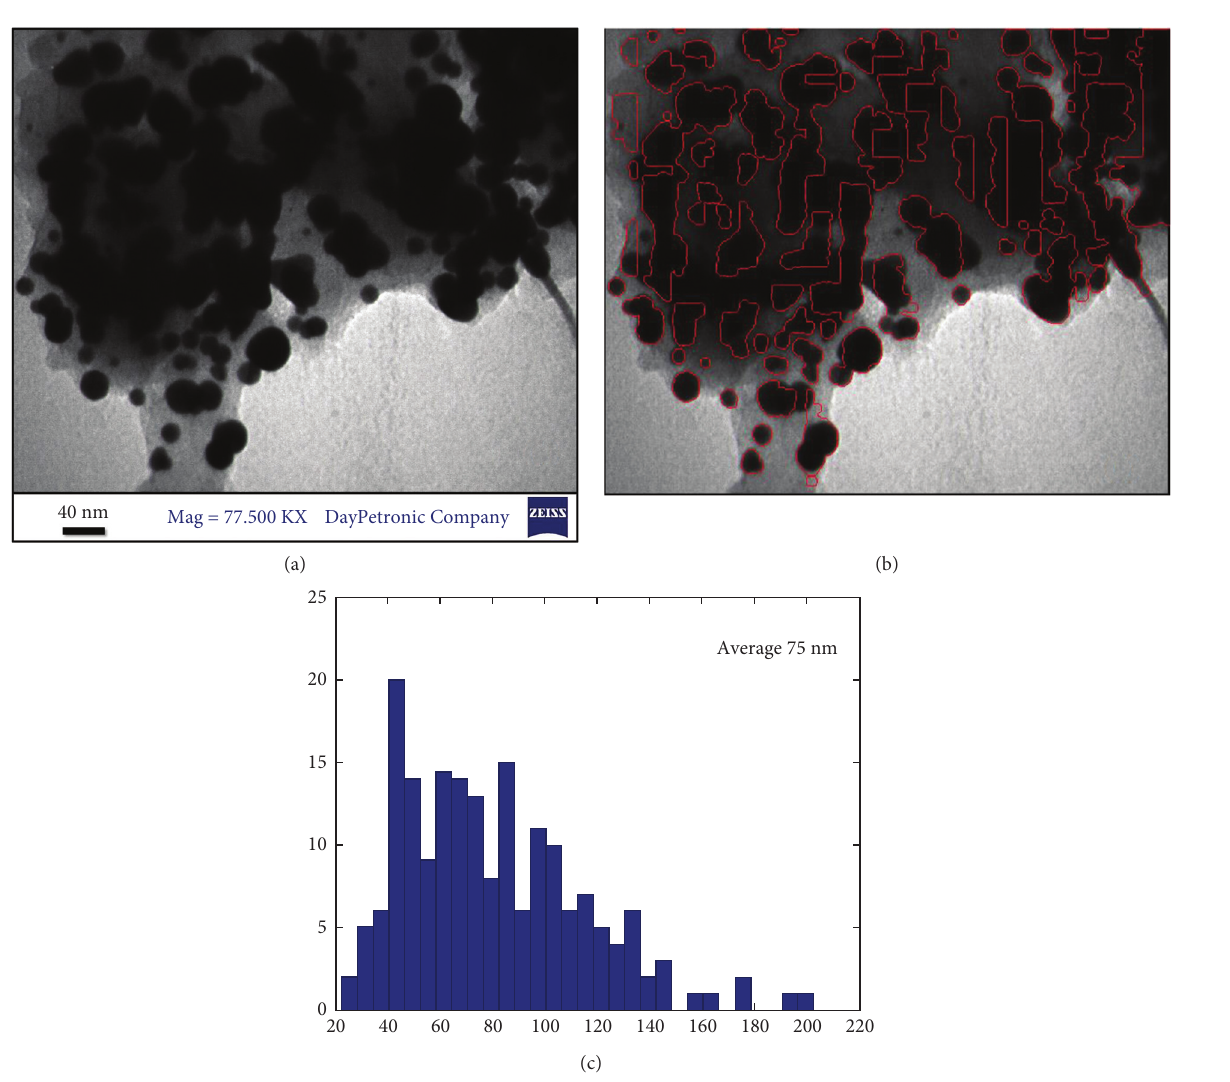
Figure 6: (a) The original TEM image, (b) particles which were detected by local thresholding, and (c) particle size distribution diagram obtained from the analysis of the TEM